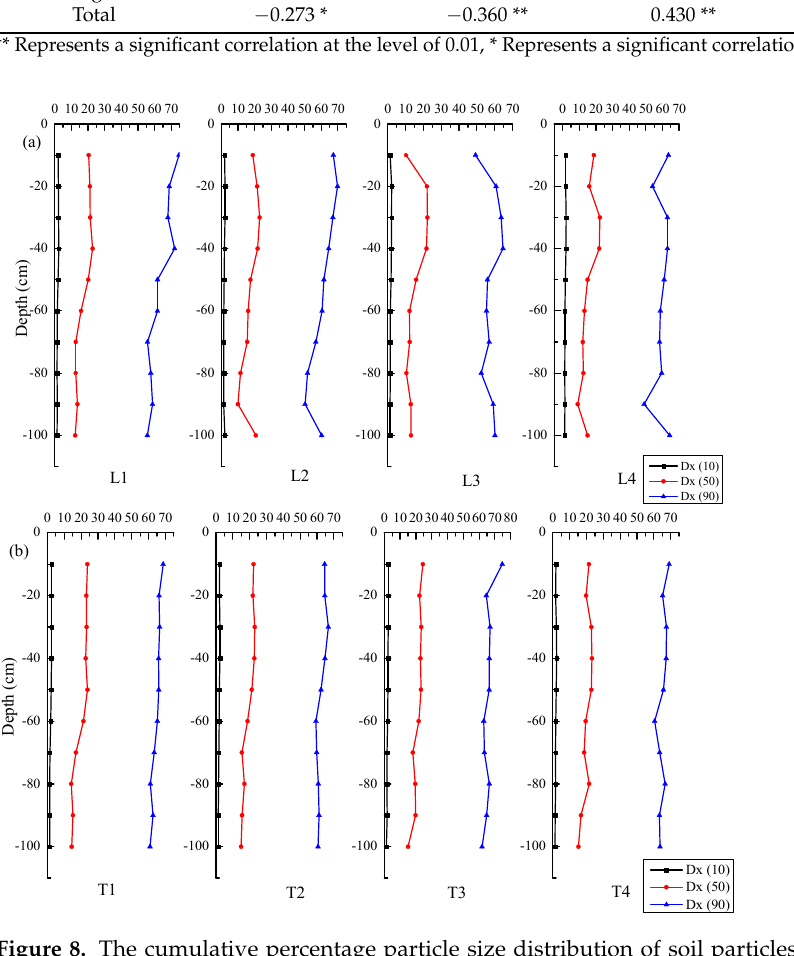
Figure 8. The cumulative percentage particle size distribution of soil particles in different areas of the root zone, ( a ): L1–L4, ( b ): T1–T4. (DX (10), DX (50), and DX (90) indicate that the mass of particles smaller than the particle size accounts for 10%, 50%, and 90%, respectively, of the total mass of particles).